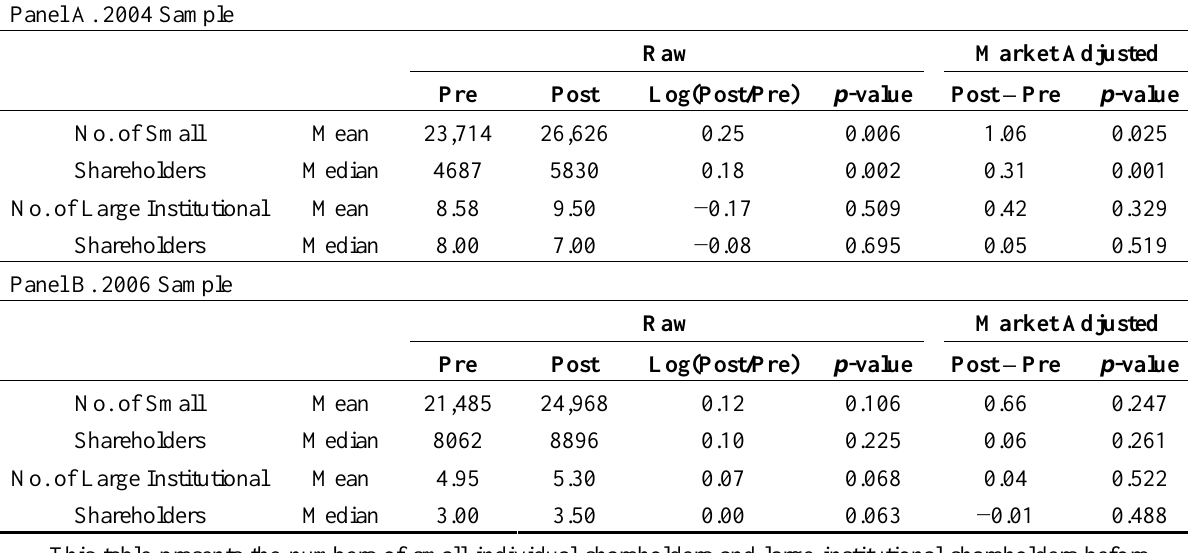
Table 2. Number of